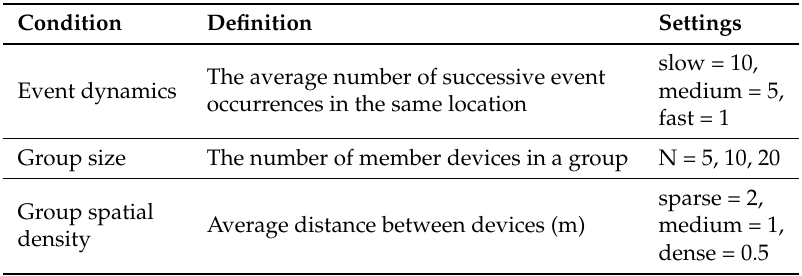
Table 3. Experiment configuration.